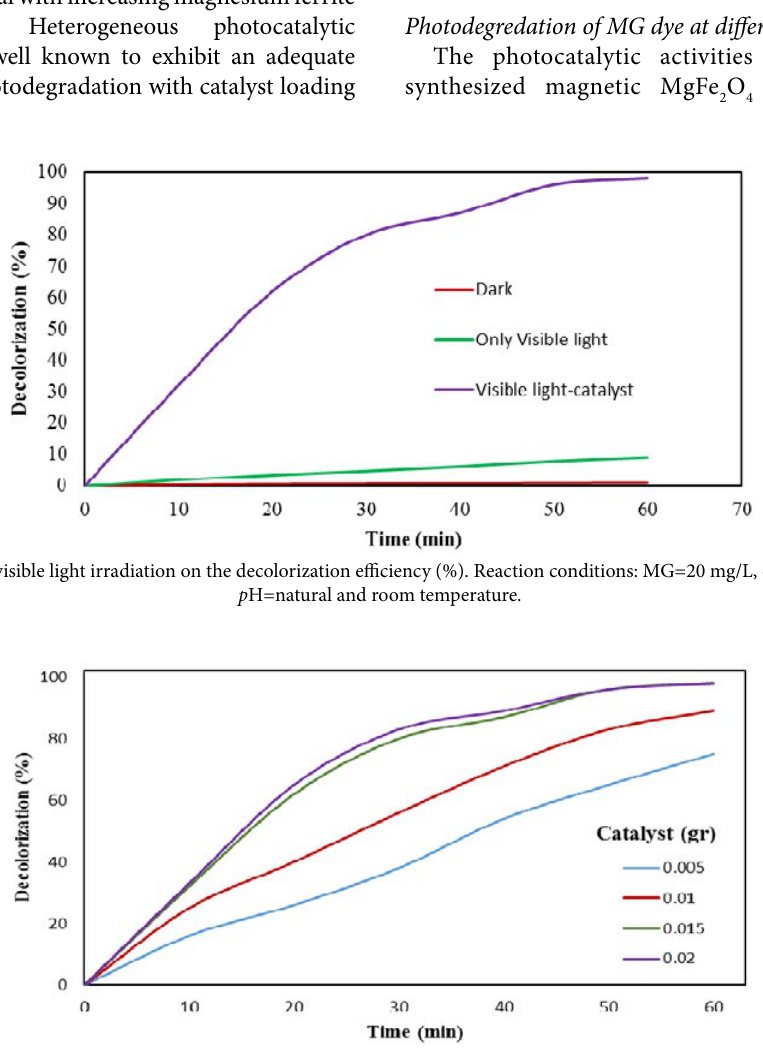
Fig. 4. The effect of photocatalyst dosage on the photocatalytic degradation of MG dye ( p H = natural, MG =20 mg/L).